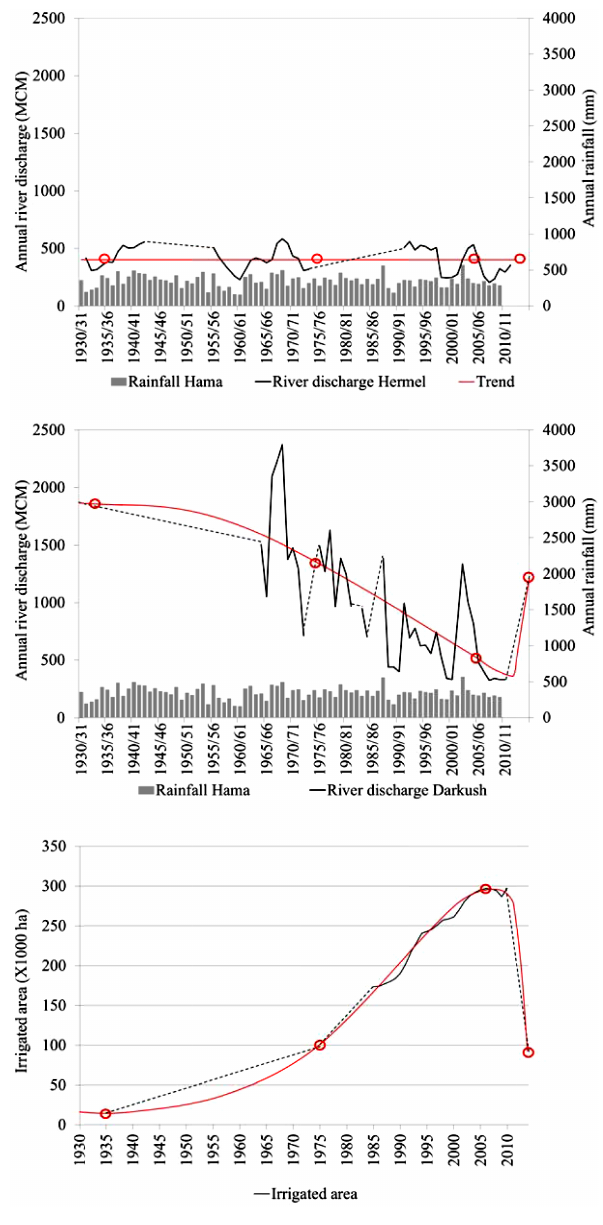
Figure 2. Changes in river discharge and irrigated areas 1930/1931–2013/2014. River discharge series from UN-ESCWA and BGR